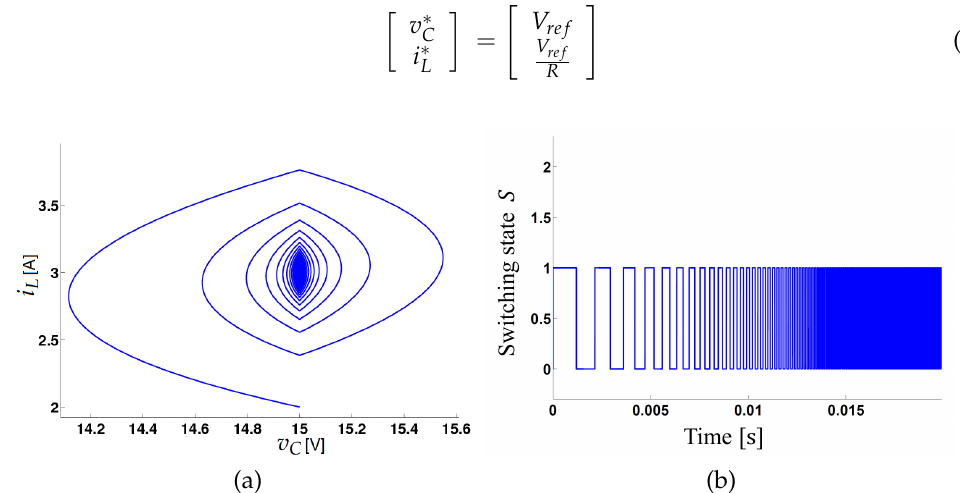
Figure 11. Dynamics when considering symmetric vector fields with V ref = 15 V: ( a ) phase diagram and ( b ) temporal evolution of switching pattern for switch S